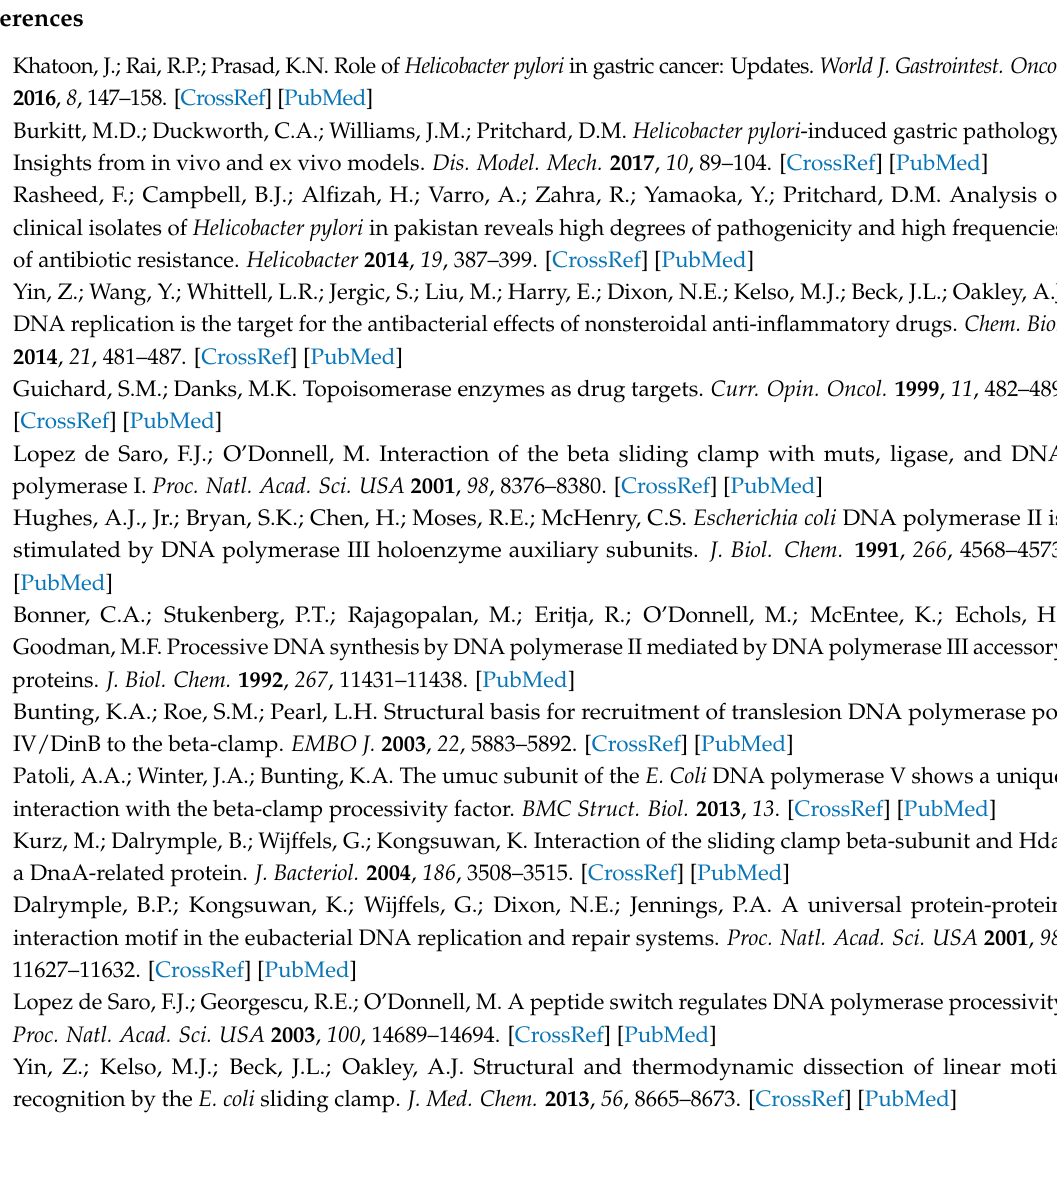
Supplementary Materials: The following are available online at www.mdpi.com/2079-6382/7/1/5/s1, Figure S1: Surface representation of co-crystal structure of Hp β -clamp monomer with ligase peptide and various inhibitors. Figure S2: Structural alignments of Hp β -clamp-inhibitor co-complexes with the Hp β -clamp-inhibitor docking models. Table S1: The list of E. coli β -clamp inhibitors along with their structures, docking scores and binding energy values with Hp β -clamp. Table S2: Table showing residues of Hp β -clamp that interact with ligase peptide and its inhibitor molecules. Also the corresponding residues of Ec β -clamp that are involved in binding with inhibitors have been